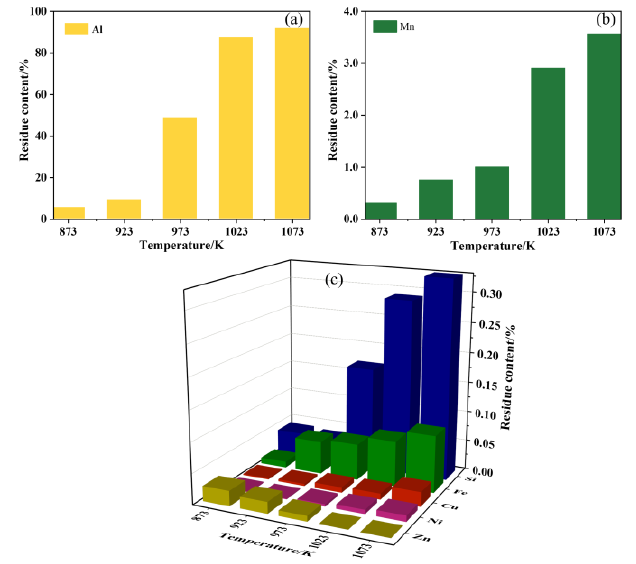
Figure 4. Main impurity contents in Mg residues at different temperatures (( a ) Al impurity content; ( b ) Mn impurity content; ( c ) Other impurity contents).